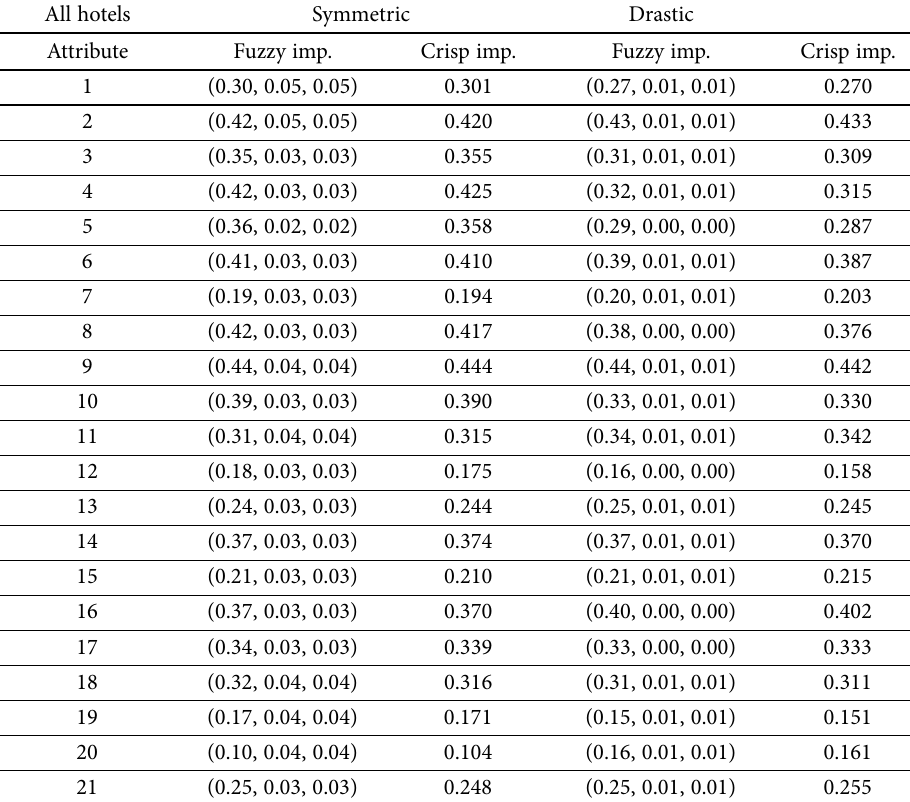
Table 5. Fuzzy importance and crisp importance of attributes – All hotels